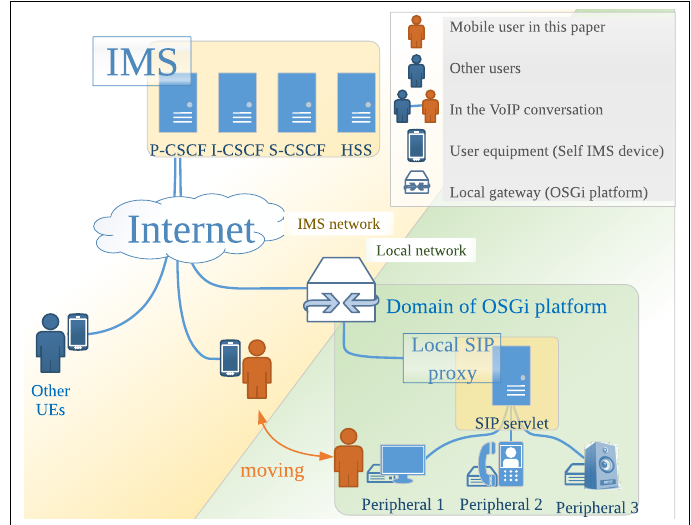
Figure 8. Architecture of the experimental